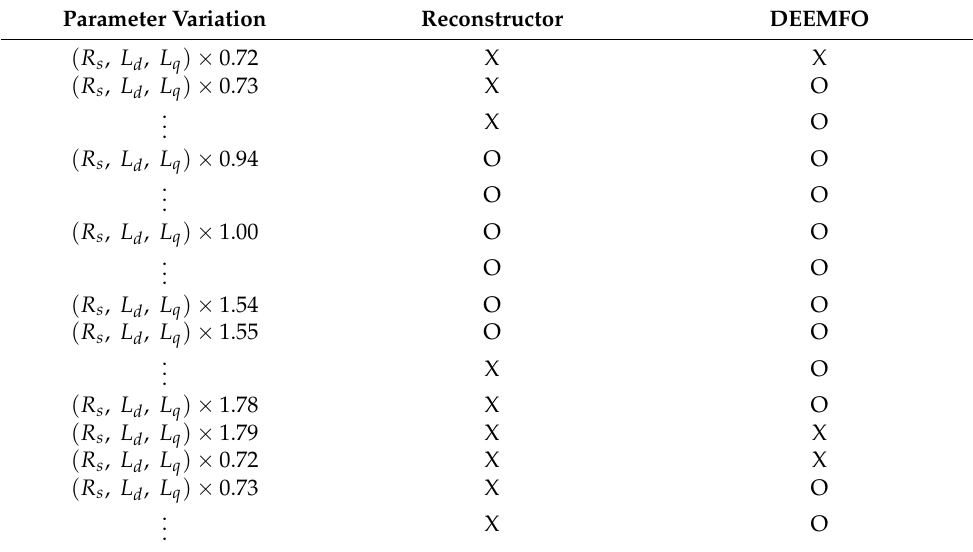
Table 2. Speed control result according to parameter change.